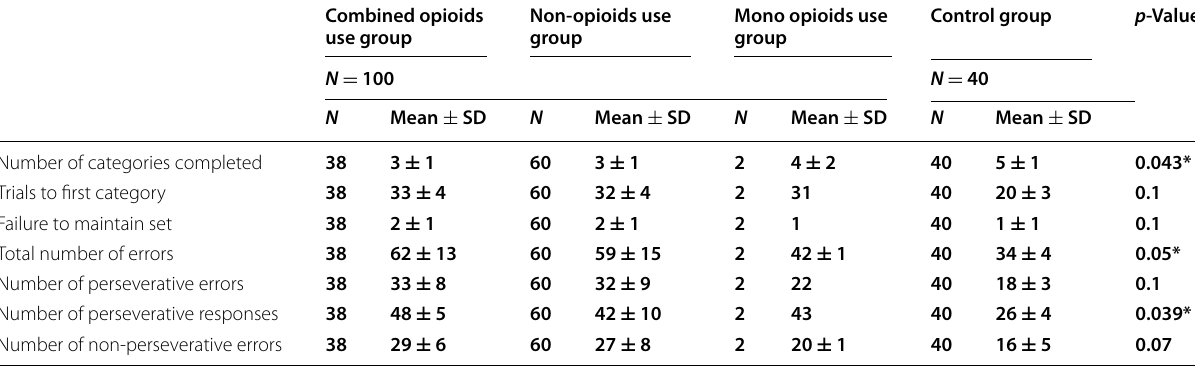
Table 6 Comparison between mono opioid, combined opioid, and non-opioid use groups with control group regarding WCST domains